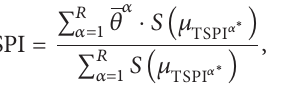
Figure 1. Triangular membership functions are used in this study because they are easy to define; only three parameters are required: a modal point, the upper width, and the lower width. In addition, due to their conceptual and computation simplicity, triangular fuzzy numbers are commonly used in practical applications [30, 51, 52]. The domain for the membership functions corresponding to the LHS is defined based on the absolute value of the associated performance measures; the domains for the PIs corresponding to the RHS are normalized so as to use a simple [0, 1] range. Figure 1 shows the membership functions for the calculation of the TSPI. Similar functions are defined for the other two